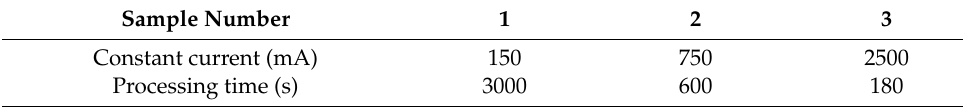
Table 3. Experimental